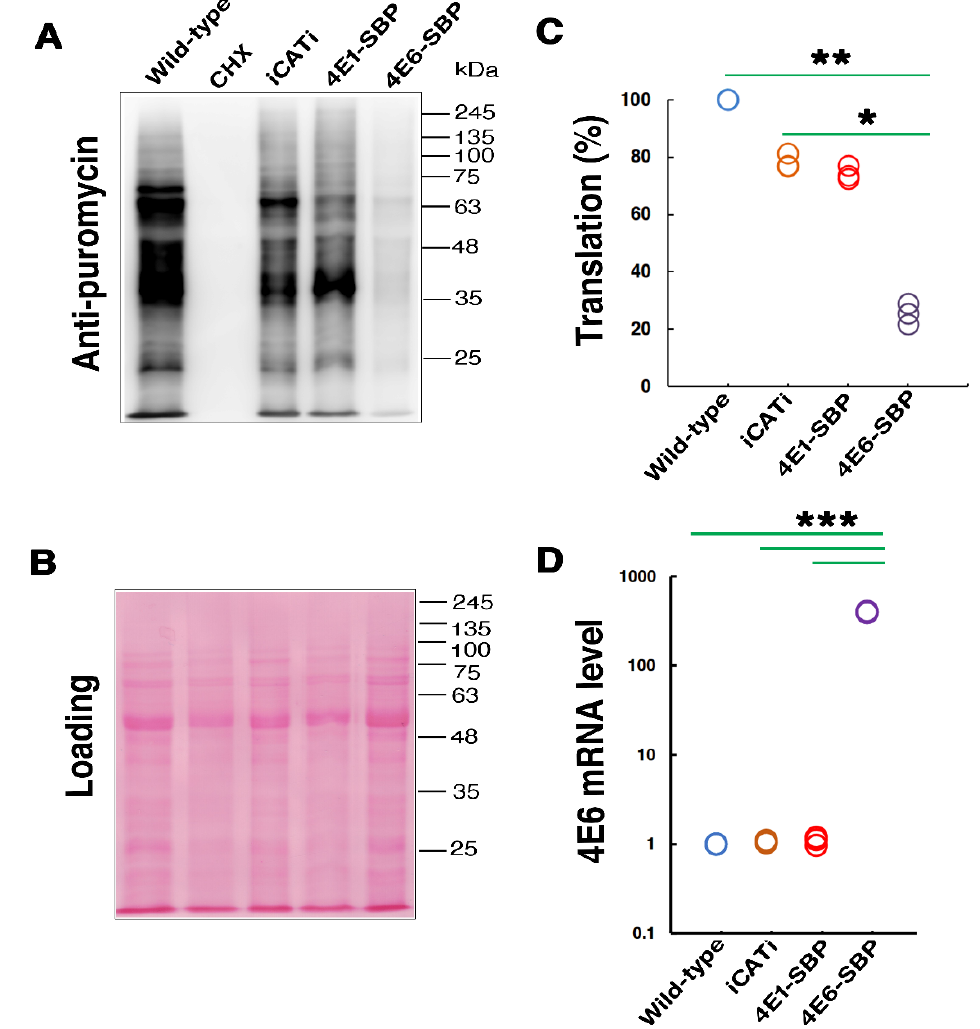
Figure 3. Overexpression of LeishIF4E-6 reduces global translation. Transgenic L. amazonensis promastigotes overexpressing the SBP-tagged LeishIF4E-6 and LeishIF4E-1, the Chloramphenicol acetyltransferase (CAT) reporter, along with wild type L. amazonensis, were examined in the SuNSET assay. ( A ) Cells were incubated with 1 µg/mL puromycin for 20 min, extracted, separated over 12% SDS-PAGE and subjected to western analysis using specific antibodies against puromycin. A cycloheximide (CHX) control for complete translation inhibition is also shown. Whole cell extracts were separated by 12% SDS-PAGE and subjected to western analysis using antibodies against puromycin. ( B ) Ponceau staining of the blot shows comparable protein loads; ( C ) densitometry data (taken with Multi-Gauge, version 2.0) quantify the puromycin incorporation in the different cell lines, as compared to puromycin incorporation in wild type cells (100%). GraphPad Prism was used for statistical analysis. Three independent experiments were performed and the individual values are presented as dots. Statistical significance was determined using a Kruskal–Wallis test with Dunn’s multiple-comparison test for comparing three or more groups. Significant p -values were marked as follows: p -value < 0.05 (*), p -value < 0.01 (**). ( D ) LeishIF4E-6 transcript levels in the different cell lines were determined by quantitative real-time PCR. The relative expression of the LeishIF4E-6 transcripts was calculated using the 2 −ΔΔ CT formula where the endogenous control GAPDH was used as the normalizer. The values of three replicates were represented as a dot plot graph. The statistical analysis was carried out using GraphPad Prism 5 and significant differences were evaluated by the non-parametric T-test using the paired t -test. Significant p -values were marked as follows: p -value < 0.001 (***).